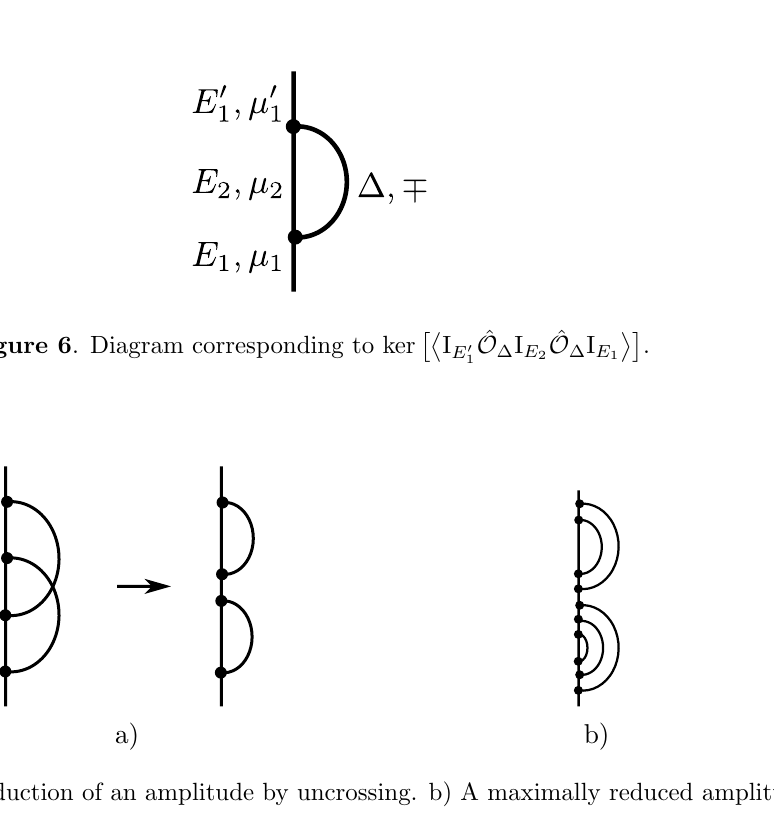
Figure 7 . a) Reduction of an amplitude by uncrossing. b) A maximally reduced